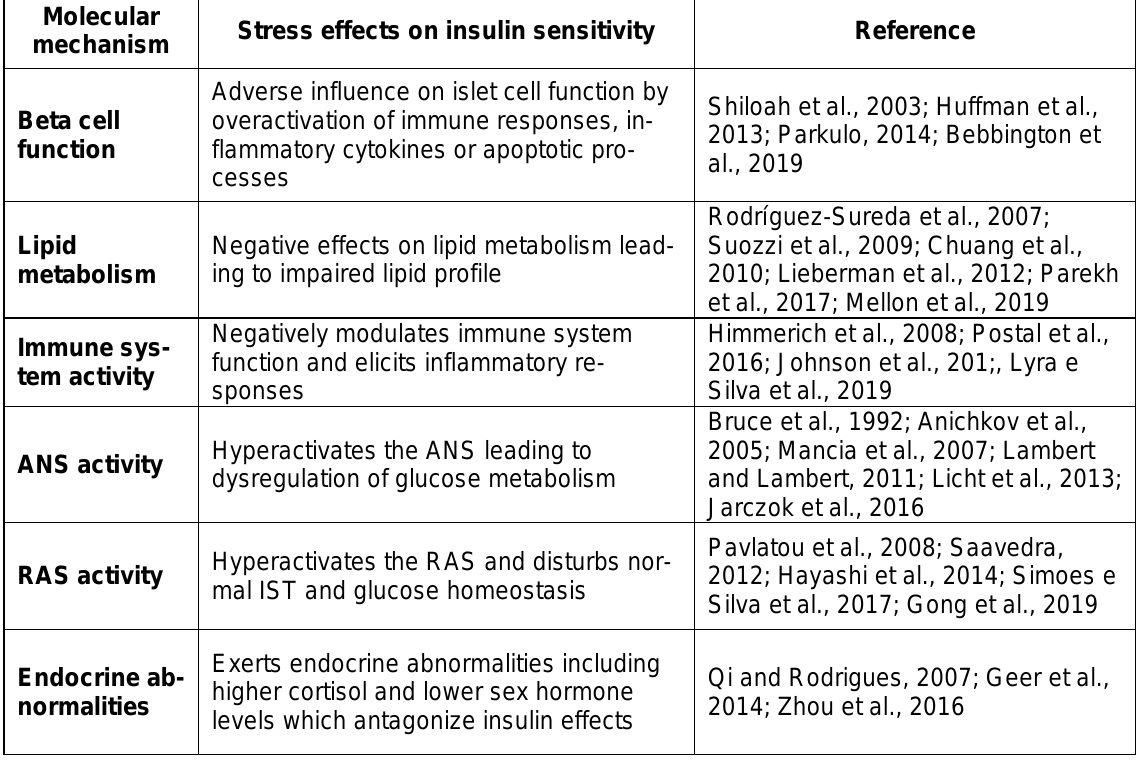
Table 2: Possible molecular interactions between stress and insulin resistance (RAS=renin-angiotensin system, ANS=autonomic nervous system, IST=insulin signal